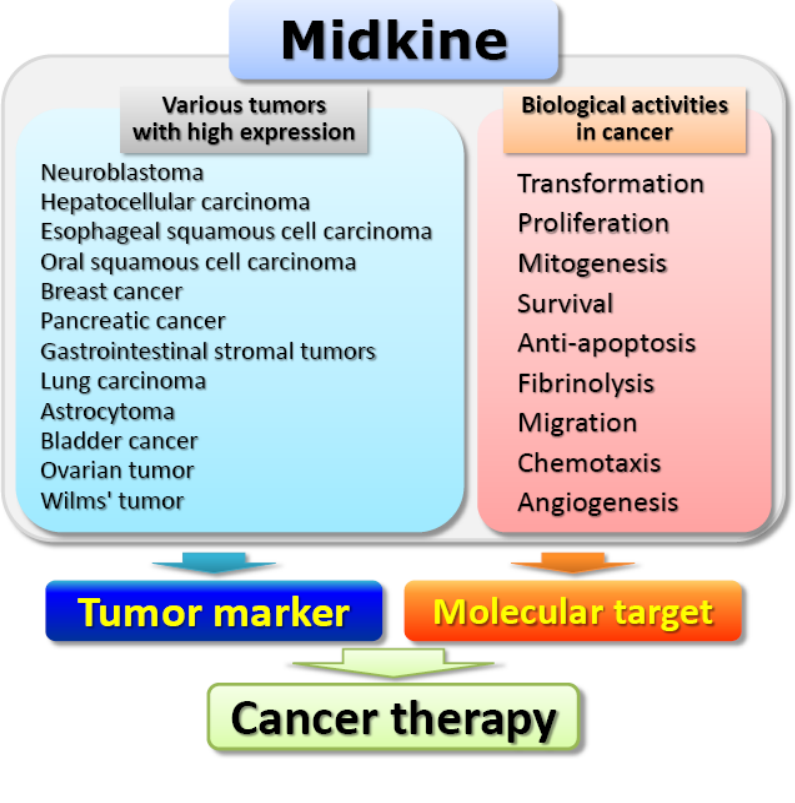
Figure 2. The clinical significance of MK in cancer